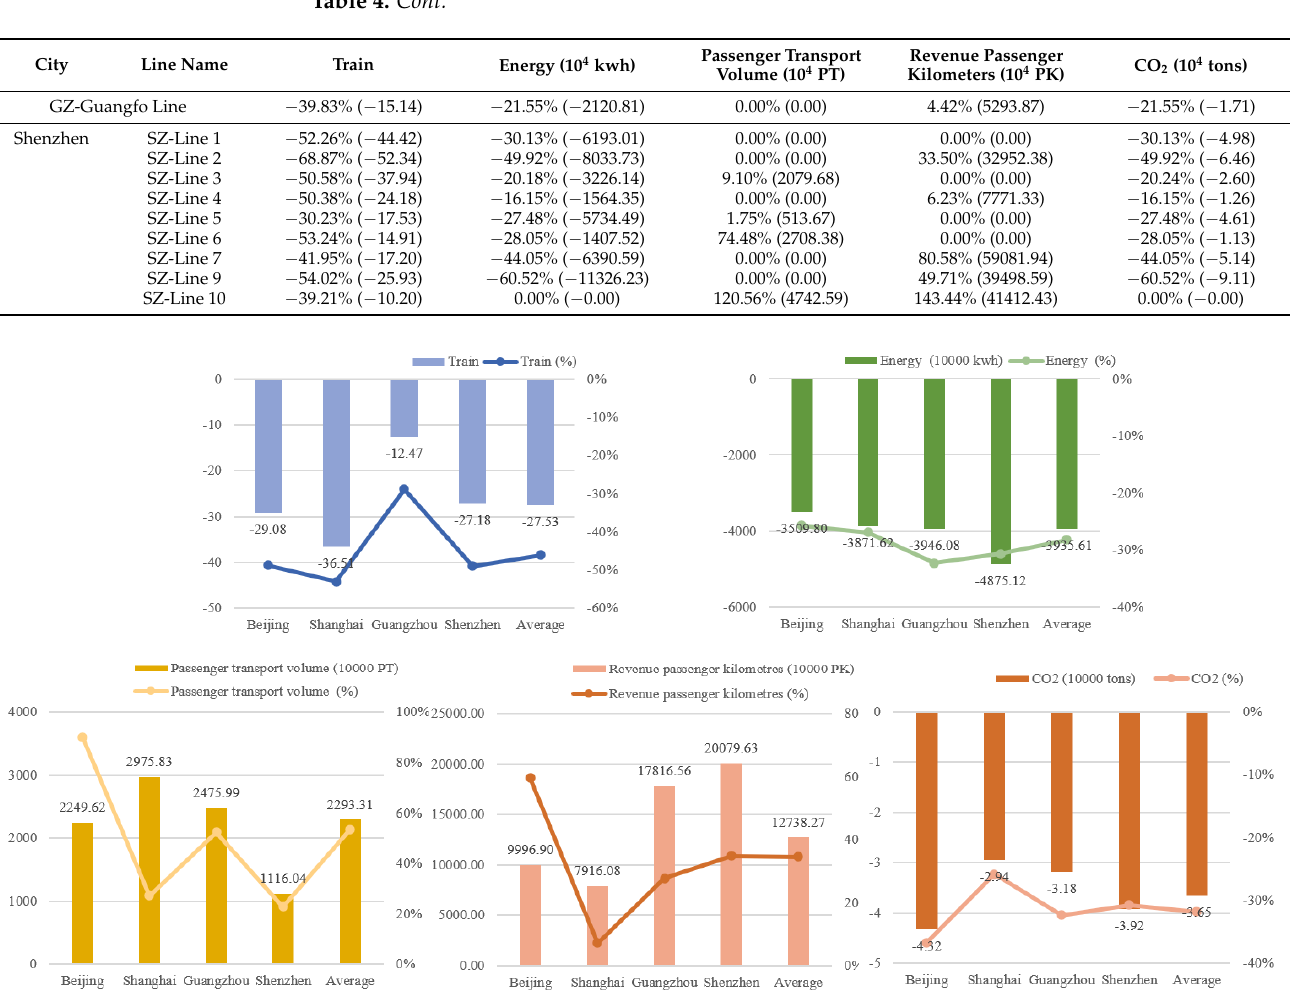
Figure 4. The average improvement values of the URT systems in case cities.